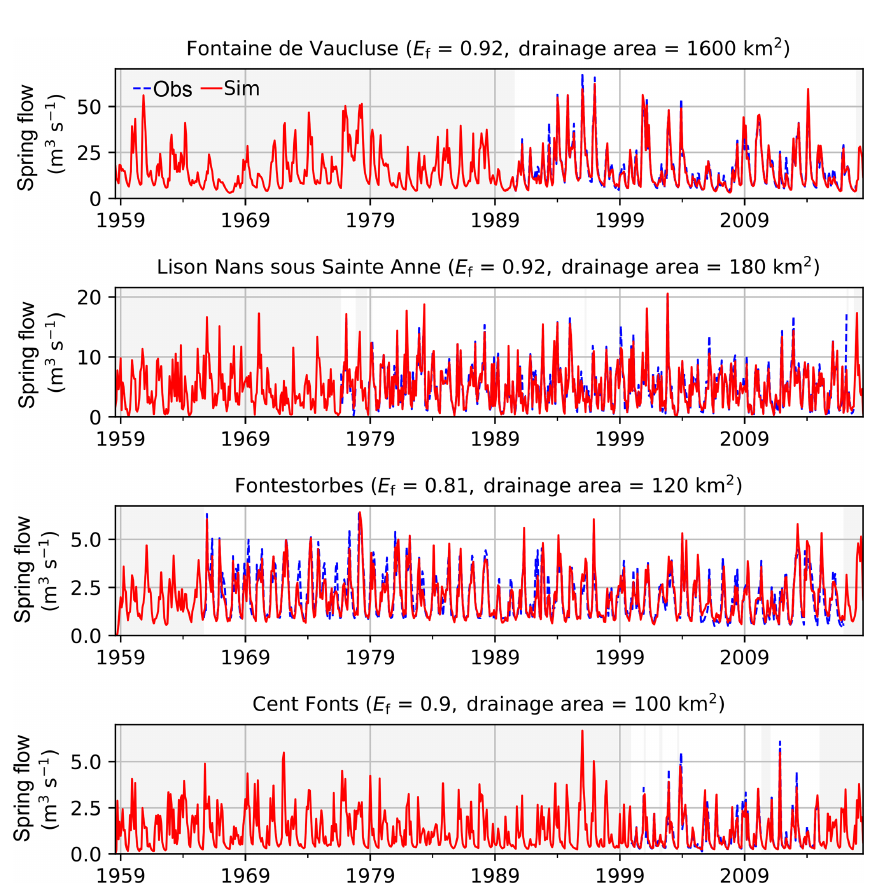
Figure 12. Monthly observed (dashed blue) and simulated (red) river flows of the gauging stations monitoring the four karstic systems encircled in red in Fig. 3. E f of the square root of the daily karstic spring flows and drainage area are given in parenthesis for each gauging station. Grey backgrounds correspond to periods of gaps in the